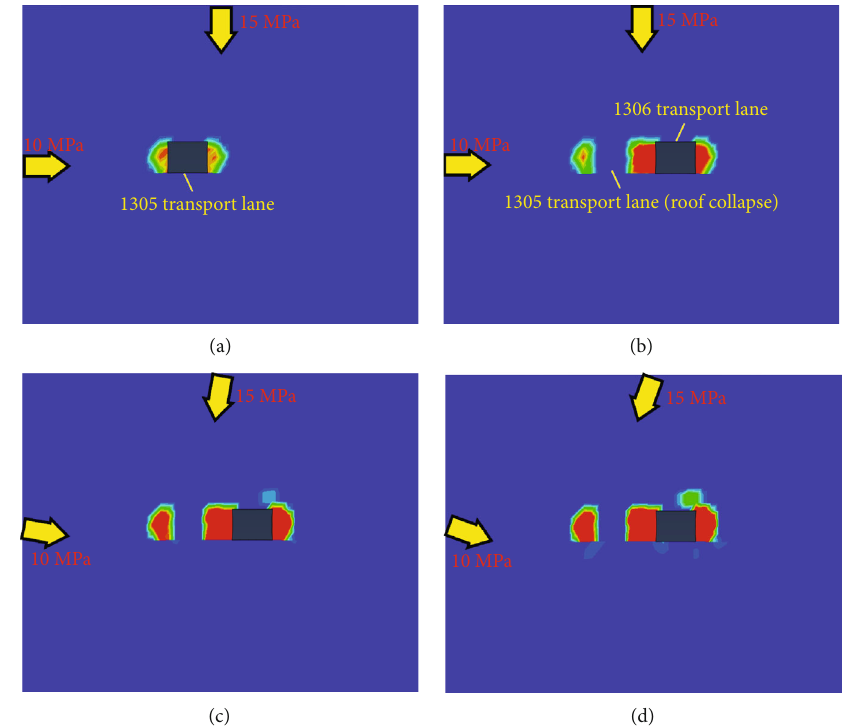
Figure 15: Variation of plastic zones in the surrounding rock mass of the entry: (a) damage of the 1305 head entry; (b – d) 1306 transport lane destruction, wherein the angle of the principal stress rotation is 0 ° , 10 ° , and 20 ° ,